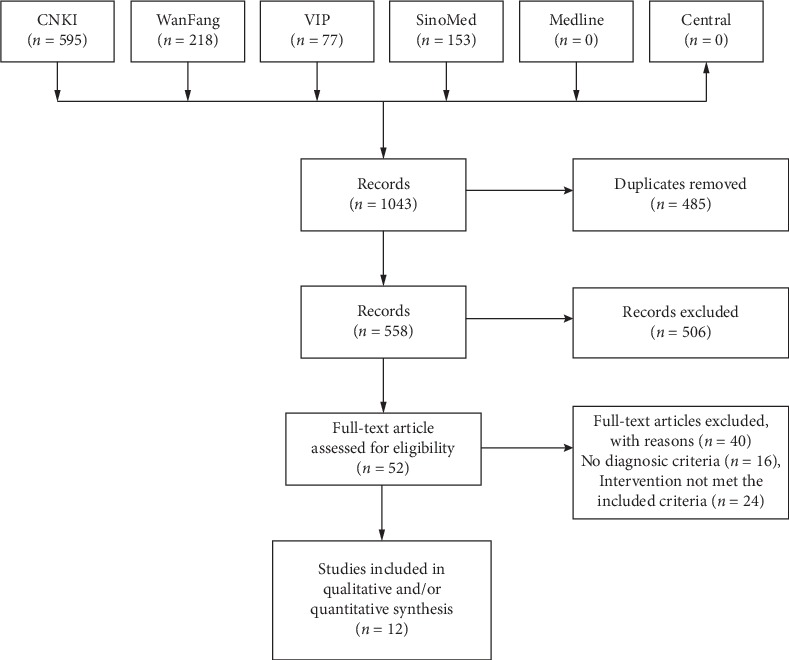
Study flow chart.